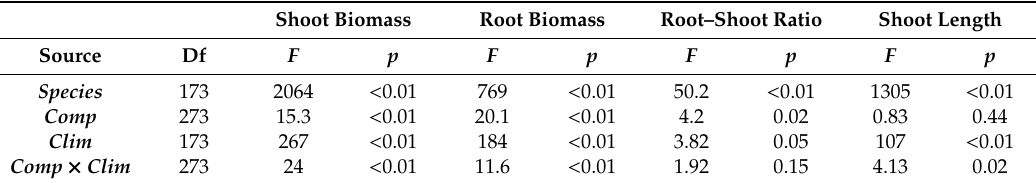
Table 2. Analysis of variance (ANOVA) table for average shoot biomass, root biomass, root–shoot ratio, and shoot length of Bromus tectorum and Ventenata dubia . Comp = Competition treatment and Clim = Climate treatment. Df = degrees of freedom. F = F-value; p = p -value. Shoot Biomass Root